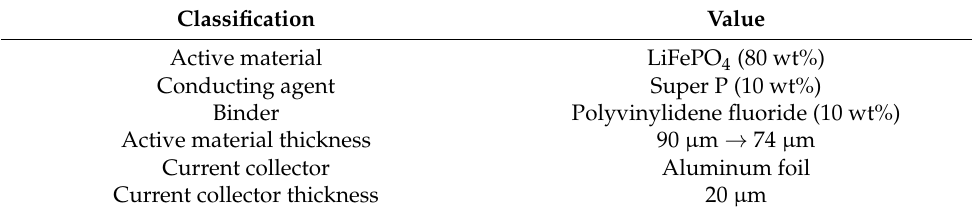
Figure 1. The schematic diagram of LiFePO 4 cathode. Table 1. The information of LiFePO 4 cathode.